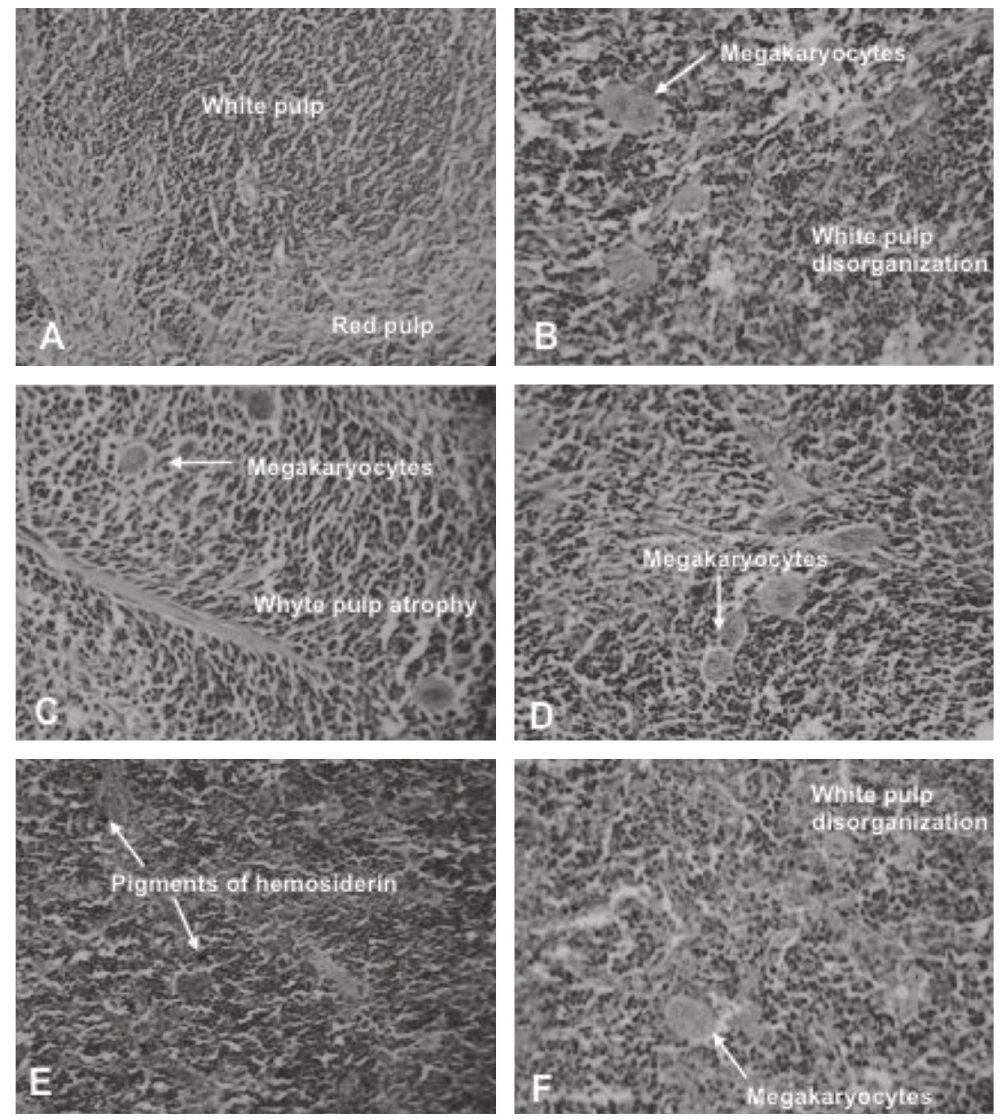
Figure 4 - Histology of spleens removed from untreated or N -phthaloyl amino acid derivatives-treated mice with 50 mg/kg/day after 7 days. A – Control (4 % DMSO); B – Thalidomide; C – 5-Fluorouracil (25 mg/kg/ day); D – Compound 3c; E – Compound 4; F – Compound 5. Hematoxylin-eosin staining. Magnification, x